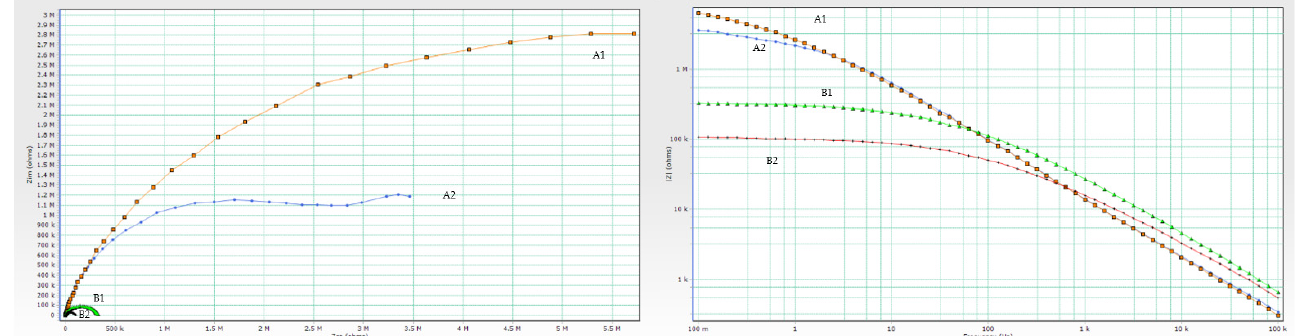
Figure 9. Overlapped Nyquist and Bode plots of coating systems after 720 h immersion in 3% NaCl.